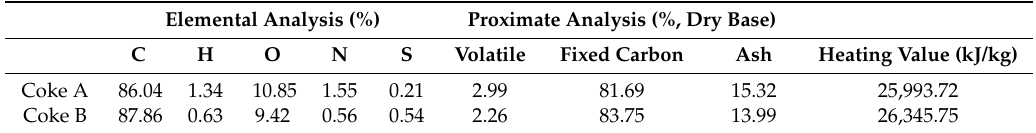
Table 6. Element and proximate analysis of coke.